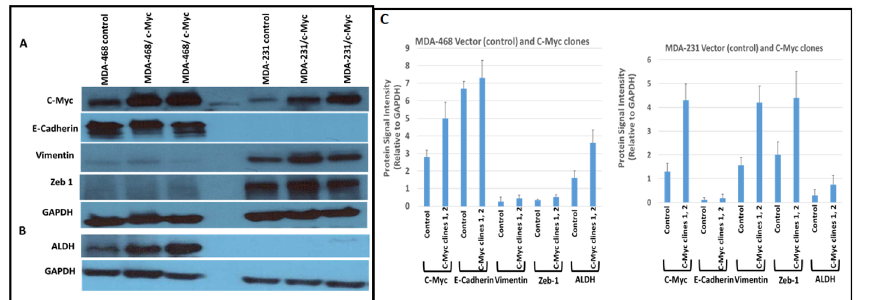
Fig 3. Effect of c-Myc overexpression on EMT and ALDH changes in MDA-MB-468 and MDA-MB-231 cell lines. In c-Myc/MDA-468, overexpression of c-Myc enhanced the levels of ALDH comparedto the control group (3B), and it had minimaleffect on EMT regulating proteins (3A). In contrast, c-Myc/MDA-231 cells exhibitedan increase in EMT proteins such as vimentin and Zeb-1 comparedto control MDA-231cells. In 3C protein levels are presentedrelativeto the GAPDH. Data are mean ± SD multipleindependentexperiments of control vector and two independent clones of c-Myc.